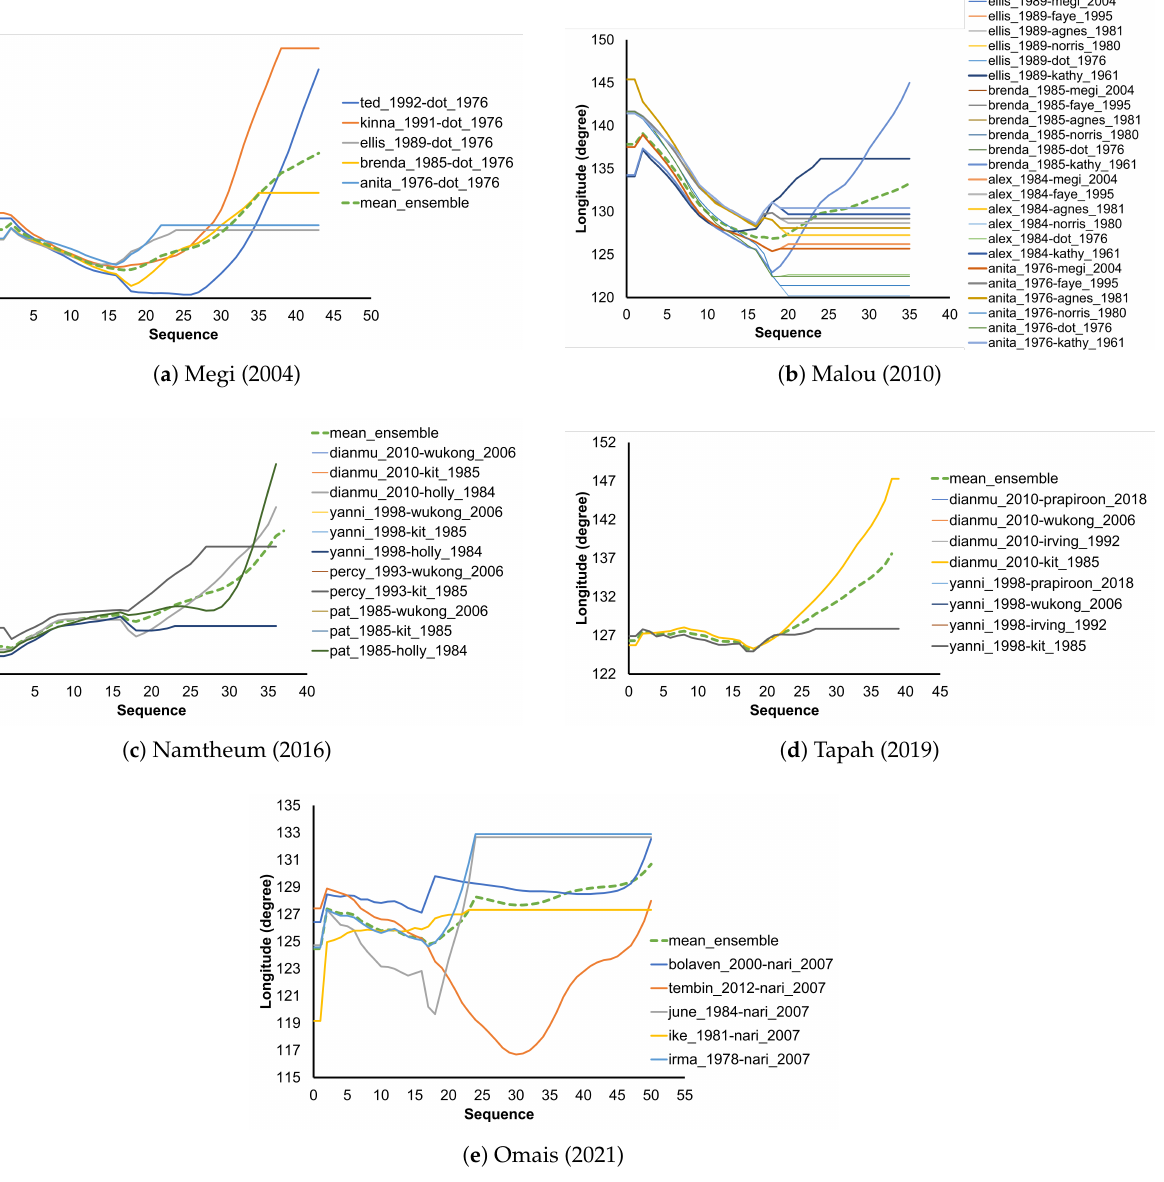
Figure 9. Typhoon track prediction for zonal component: ( a ) Megi 2004, ( b ) Malou 2010, ( c ) Namtheum 2016, ( d ) Tapah 2019 and ( e ) Omais